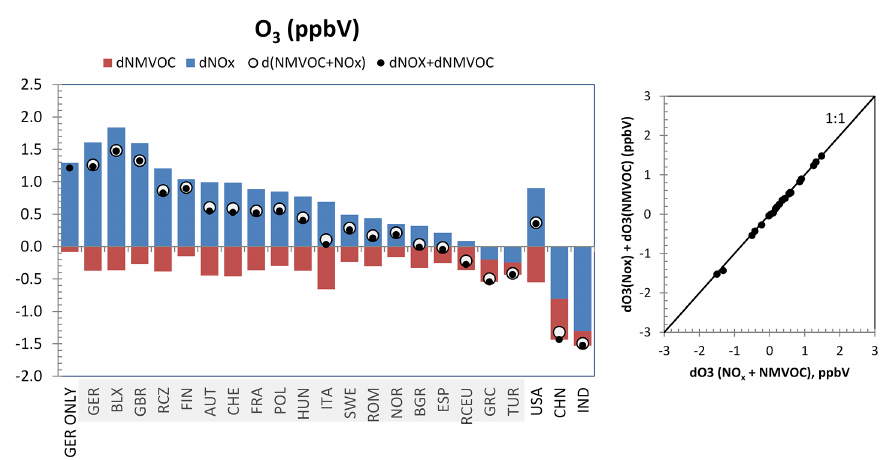
Figure 5. TM5 CTM response in annual mean population-weighted O 3 concentration (ppbV) upon emitted precursor perturbation of − 20% for selected source–receptor regions. European regions were perturbed simultaneously. Red bar: response form NMVOC-only perturbation (simulation P4); the blue bar shows the response form NO x -only perturbation (simulation P3). Open circles show the response from simul- taneous (NMVOC + NO x ) perturbation (simulation P5). Black dots show the sum of individual responses. Shaded regions are perturbed simultaneously as one European region. The right panel shows the scatter plot between O 3 response to combined and summed individual